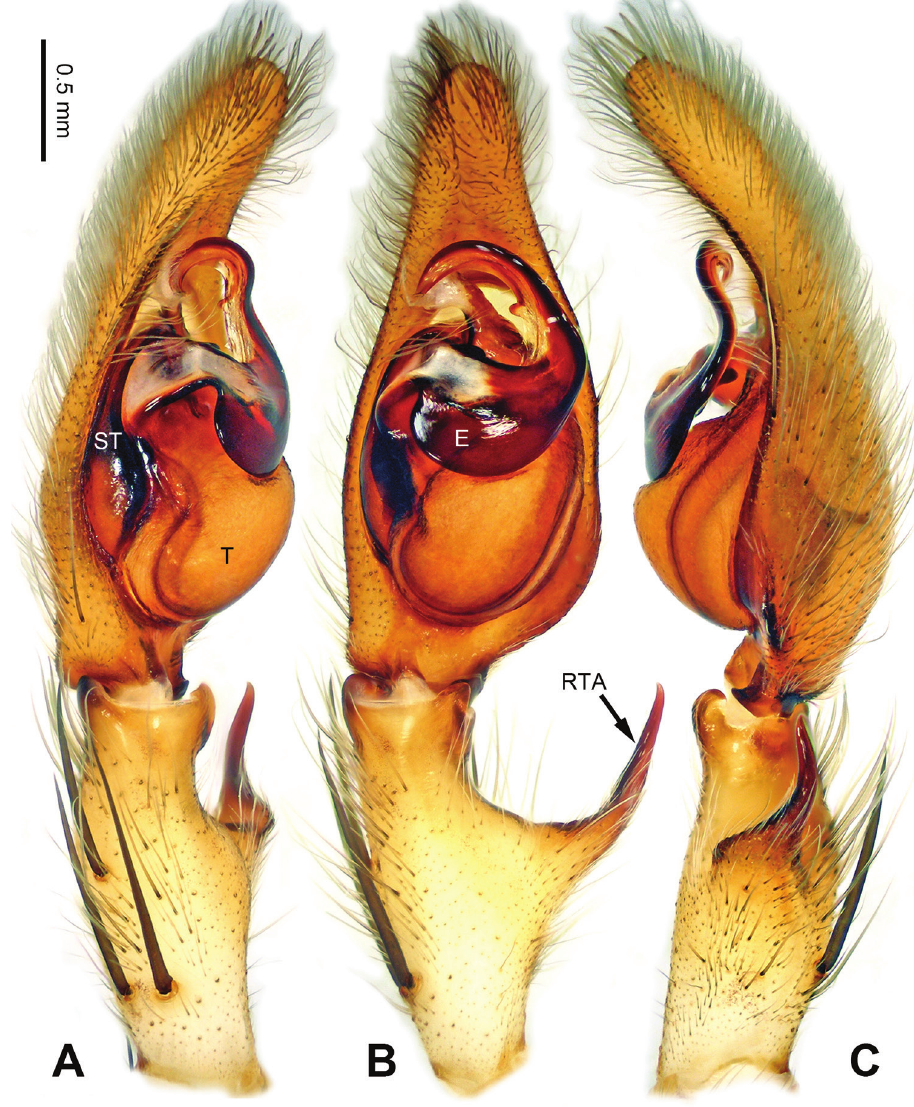
Figure 14. Pseudopoda medogensis Zhao & Li, sp. n., left palp of male holotype. A Prolateral view B Ventral view C Retrolateral view. Scale bar equal for A, B, C